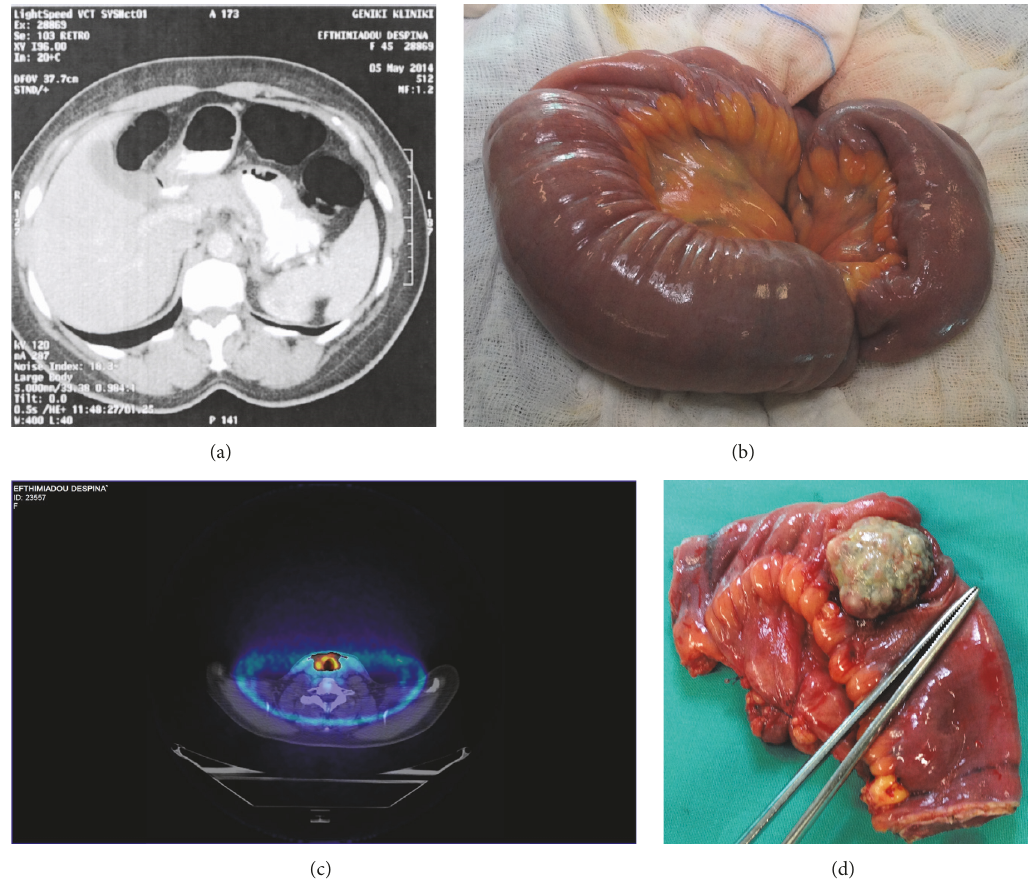
Figure 1: (a) CT scan showing an obstructing abdominal mass originating from the small bowel and causing intussusception; (b) intraoperative image of the intussusception; (c) thyroid gland with increased SUV in the 18FDG-PET/CT; (d) intestinal intussusceptions due to what appeared to be a distant melanoma